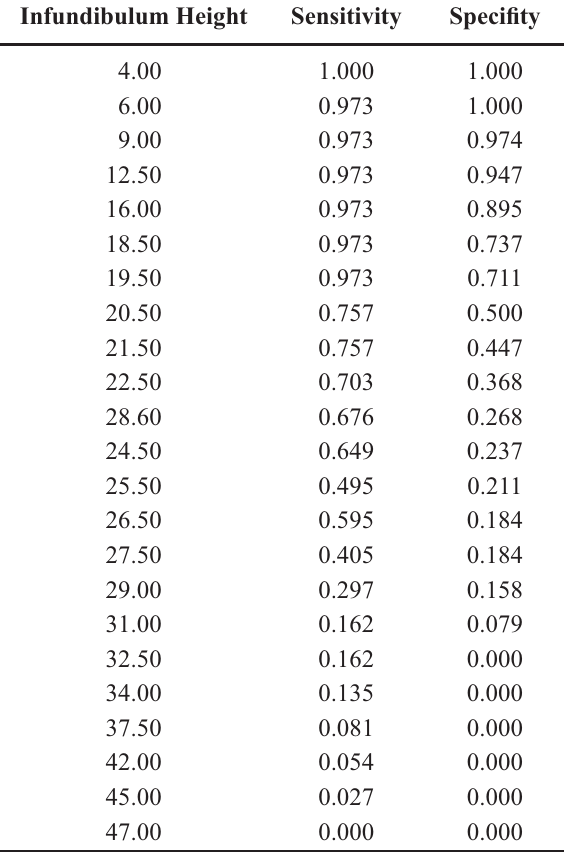
ROC Curve Coordinaters